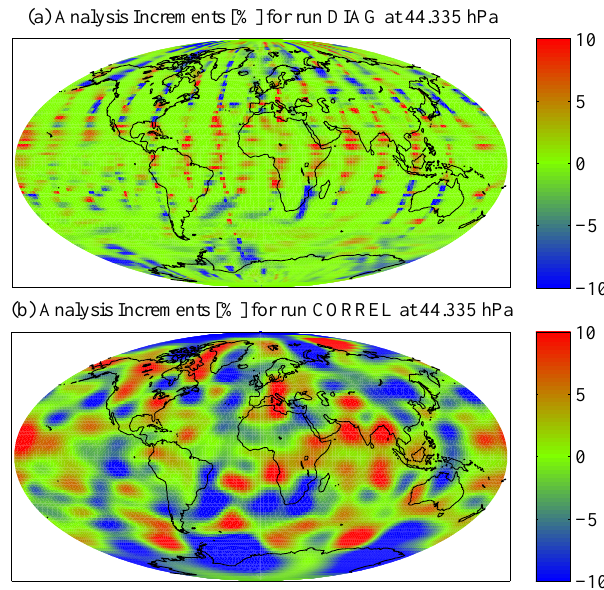
Fig. 4. Analysis increments of the runs DIAG (a) and CORREL (b) at the model level 21 ( ∼ 44hPa) on 15 September 2003, in percent. Blue and red indicate, respectively, negative and positive increments while green indicates close to zero